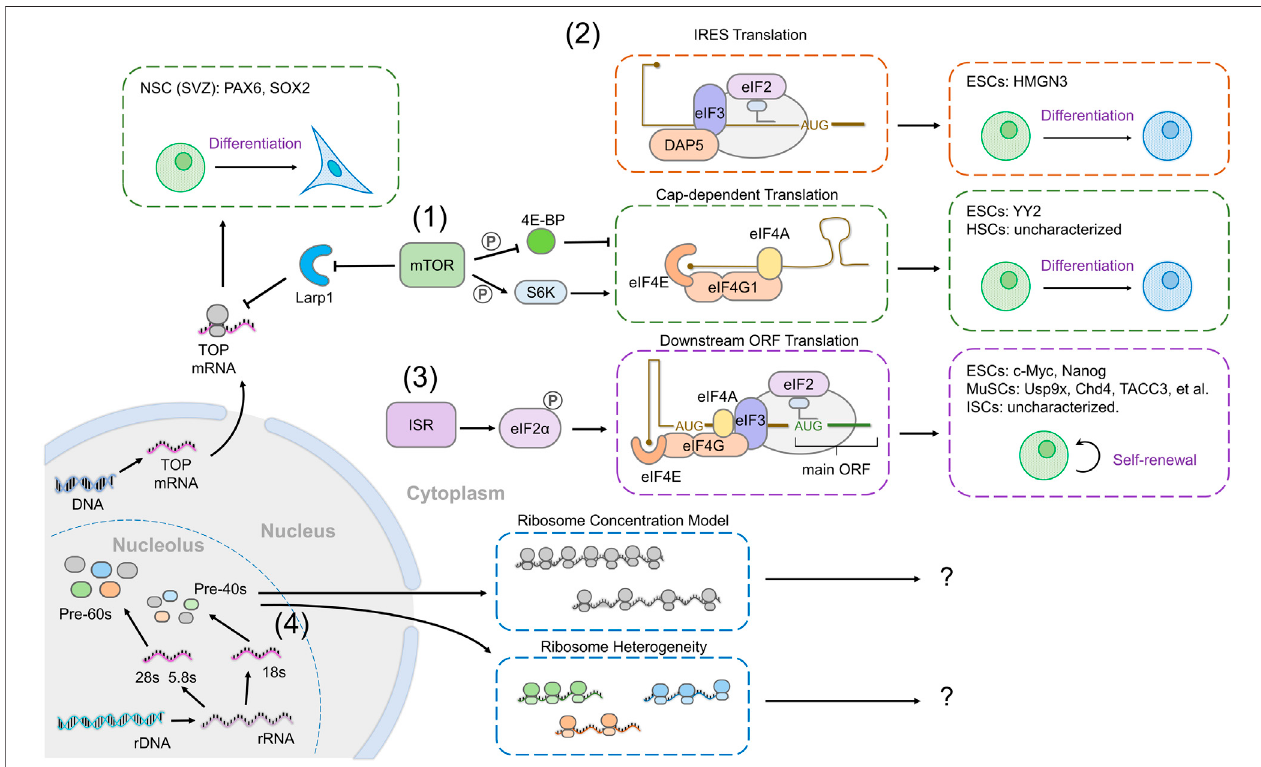
FIGURE 3 | Global translation mechanisms result in selective translation of speci fi c transcripts to regulate stem cell fate. (1) Increased cap-dependent translation downstreamofmTORactivity canresultinselectivetranslation oftranscripts thathavelowtranslation ef fi ciency. InESCs, themRNAencoding YY2isonesuch target,in other tissues (HSCs), whether mTOR activity results in speci fi c target expression is unknown (green box). mTOR also promotes the translation of mRNAs with TOP-like motifs, such as PAX6 and SOX2, which are translationally repressed during neuronal differentiation, in response to reduced mTOR activity. (2) Internal ribosome entry site (IRES)-mediated translation occurs when cap-binding is inhibited and can direct transcript-speci fi c translation. In ESCs, DAP5 replaces eIF4G to promote IRES-dependent translation and ESC differentiation, through translation of HMGN3 (orange boxes). (3) p-eIF2 ɑ selectively promotes the translation of mRNAs with an upstream open reading frame (uORF). In ESCs, p-eIF2 ɑ promotes the translation of the mRNAs encoding c-Myc and Nanog. In MuSCs, p-eIF2 ɑ promotes the translationofmRNAscodingforUsp9x,Chd4,TACC3,etc.(purplebox).(4)RibosomescanselectivelyregulatemRNAtranslation.Twomodelshavebeenproposed,the ribosome concentration model in which the amount of ribosomes available affects the translation of transcripts with high or low translation ef fi ciency differently, or ribosome heterogeneity in which different ribosomal subunit composition directs speci fi c translation of particular transcripts (blue boxes). Although ribosomes impact stem cell fate, no evidence directly supports either model to